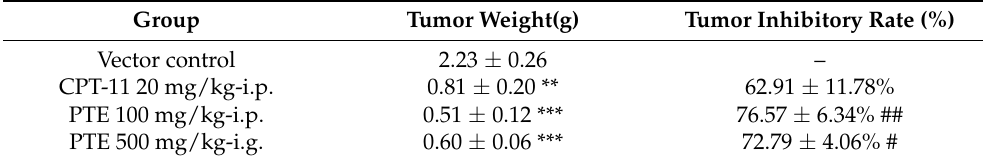
Table 3. The tumor inhibition rate of each administration group on in situ colorectal cancer tumor in nude mice (mean ± SD, n = 6). Group Tumor Weight(g) Tumor Inhibitory Rate (%) Vector control 2.23 ± 0.26 – CPT-11 20